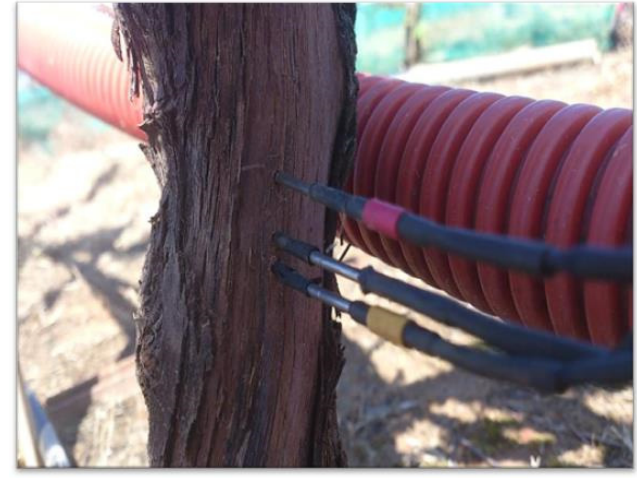
Figure 2. Installation detail of the sap flow sensor.